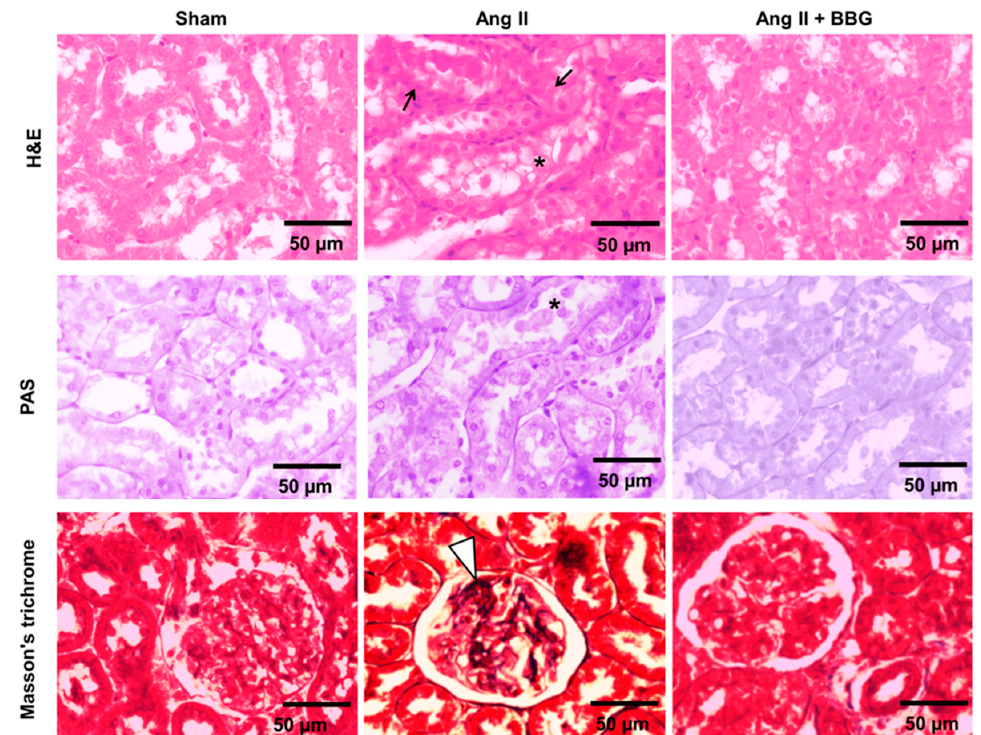
Figure 3. Representative histological microphotographs stained with hematoxylin and eosin ( H&E, first row ), periodic acid Schiff ( PAS, second row ), and Masson´s trichrome ( third row ) in renal cortex of rats in Sham, Ang II and Ang II + BBG groups ( n = 7 per group). In the Ang II group, there are areas of tubulointerstitial cell injury with intratubular debris indicated with an asterisk ( ∗ ), focal areas of mononuclear infiltration indicated by black arrows and modest segmental mesangial widening in the glomeruli (white arrow head, ∇ ) are reduced in the Ang II + BBG group. Ang II = angiotensin II; BBG = brilliant blue G.